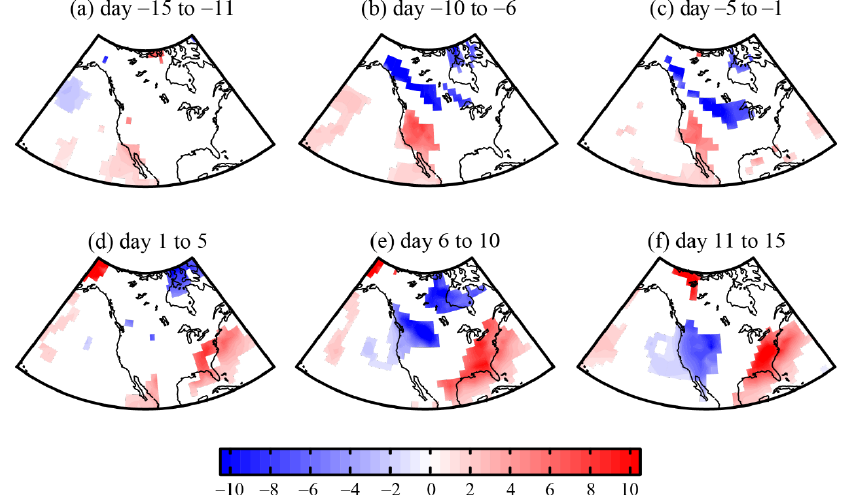
Figure 10. The 2-meter temperature anomalies (unit: K) averaged over each successive 5 days within 30 days before and after the onset date of 2018 SSW event. Shadings represent the anomalies that exceed the 0.8 standard deviations of the 2-meter temperature in February during the period 1979 – 2018.